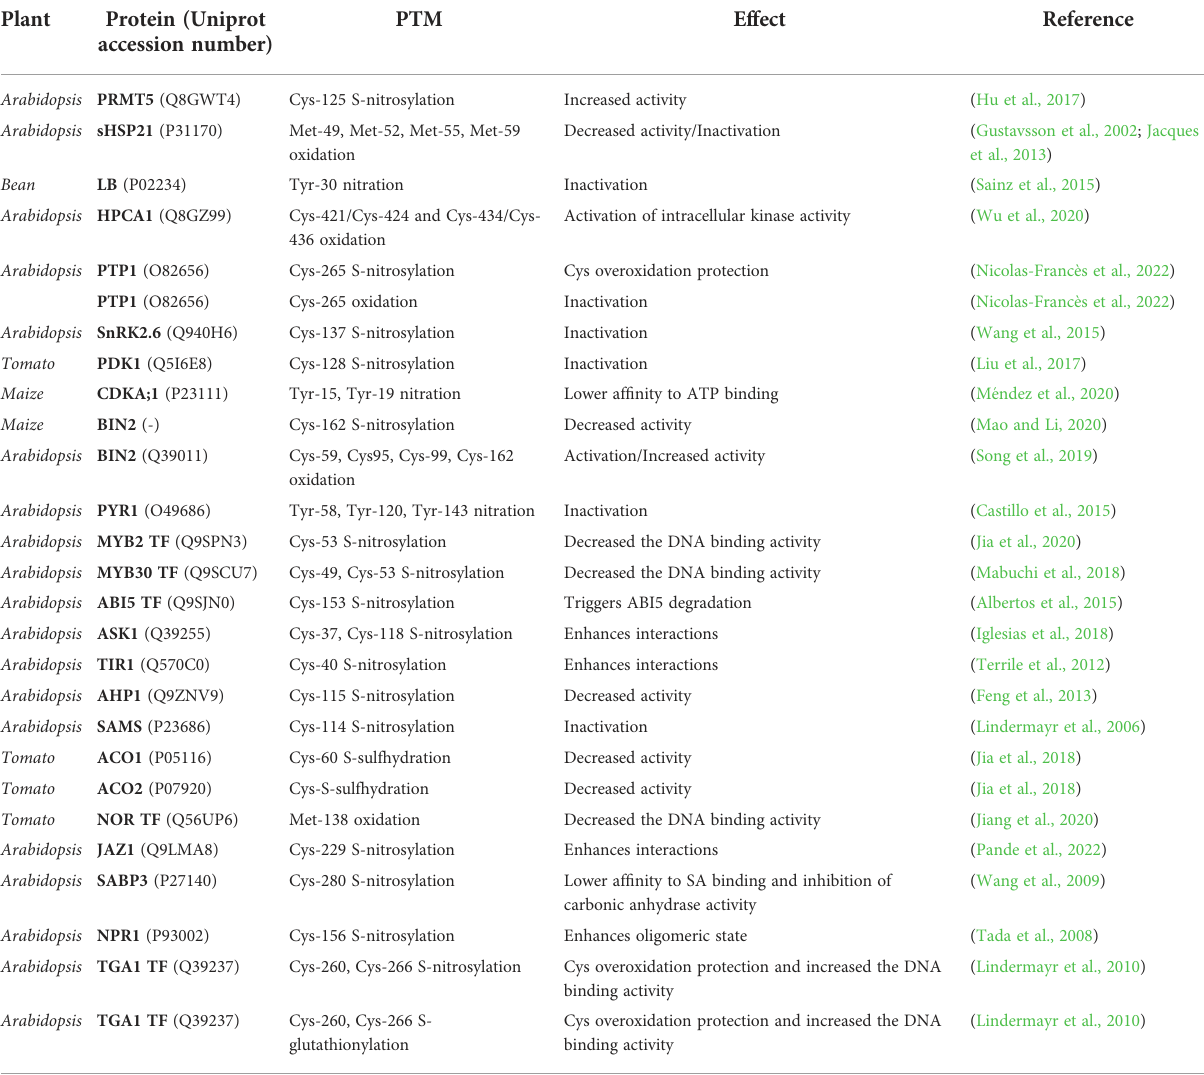
TABLE 3 PTMs and their effect on the different cellular signaling-related proteins subject to redox regulation.